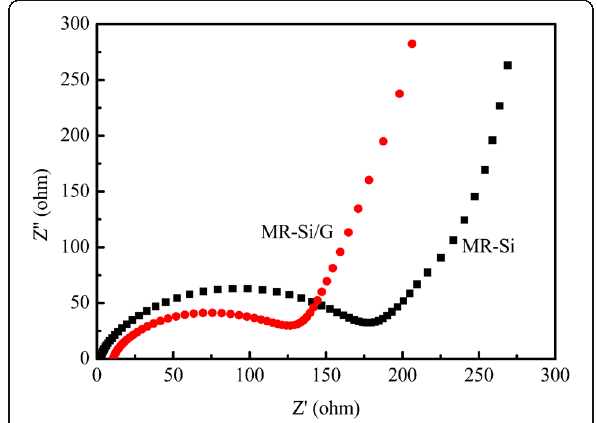
Fig. 9 Electrochemical impedance spectroscopy (EIS) of the MR-Si/G and the pure